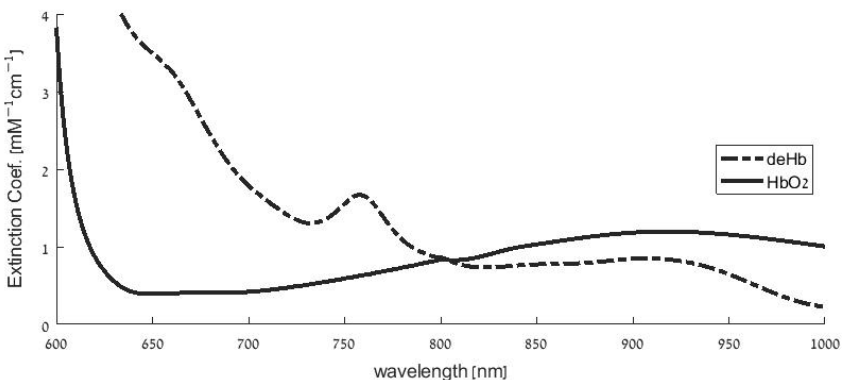
Figure 1. Extinction coefficient curves of deoxyhemoglobin (deHb) and oxyhemoglobin (HbO 2 ) in the wavelength region of red and near-infrared light. The curves are based on data obtained by Zijlstra et al. (as presented in articles by Kim and Liu [30,31]) after cubic spline interpolation [32]. To the left of the isosbestic point (the intersection of the two curves at about 800 nm), the extinction coefficient for deHb is greater than that for HbO 2 , and vice versa to the right of it.